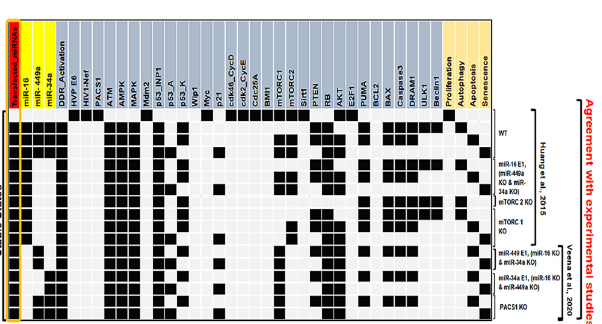
Figure 3. The wild-type state of the synthetic network and experimental verified perturbations. WT, miR-16 E1 along with miR-449a KO and miR-34a KO, mTORC2 KO, mTORC1 KO, miR-449a E1 together with miR-16 KO and miR-34a KO, miR-34a E1 along with miR-449a KO and miR-16 KO, and at the last, PACS1 KO. E1 represents gain-of-function (GoF). Whereas, KO represents loss-of-function (LoF) perturbations corresponding to referential experiments. The left-most column shows levels of Input (Transfected_miRNAs), highlighted in orange color and the right-most column presents the model outputs: Proliferation, Autophagy, Apoptosis and Senescence. Each line represents a single stable state or fixed point corresponding to the input. White cells denote a null i.e., “inactive” value, whereas black cells denote activation means “active” (value 1),